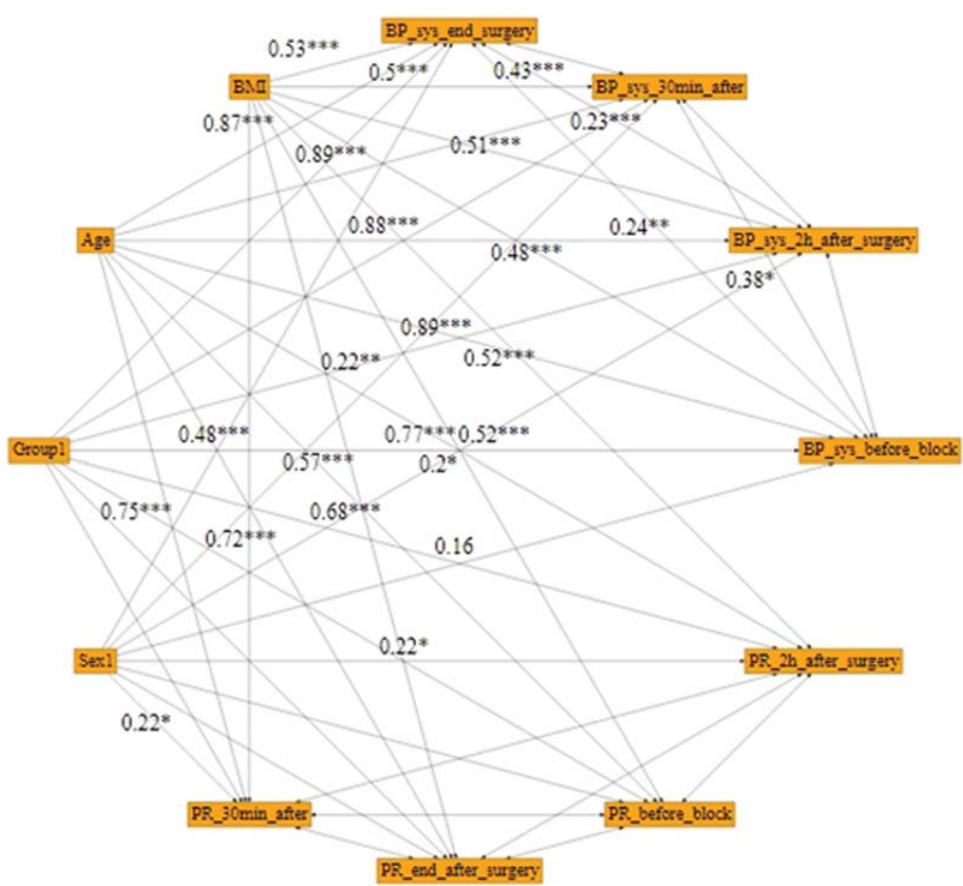
Fig. 3 Path analysis for pain-dependent variables at different